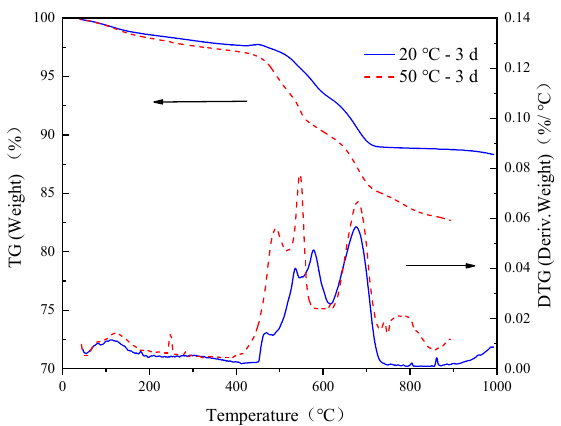
Figure 7. The effect of curing temperature at 20 °C and 50 °C on TGA/DTG for 3d.